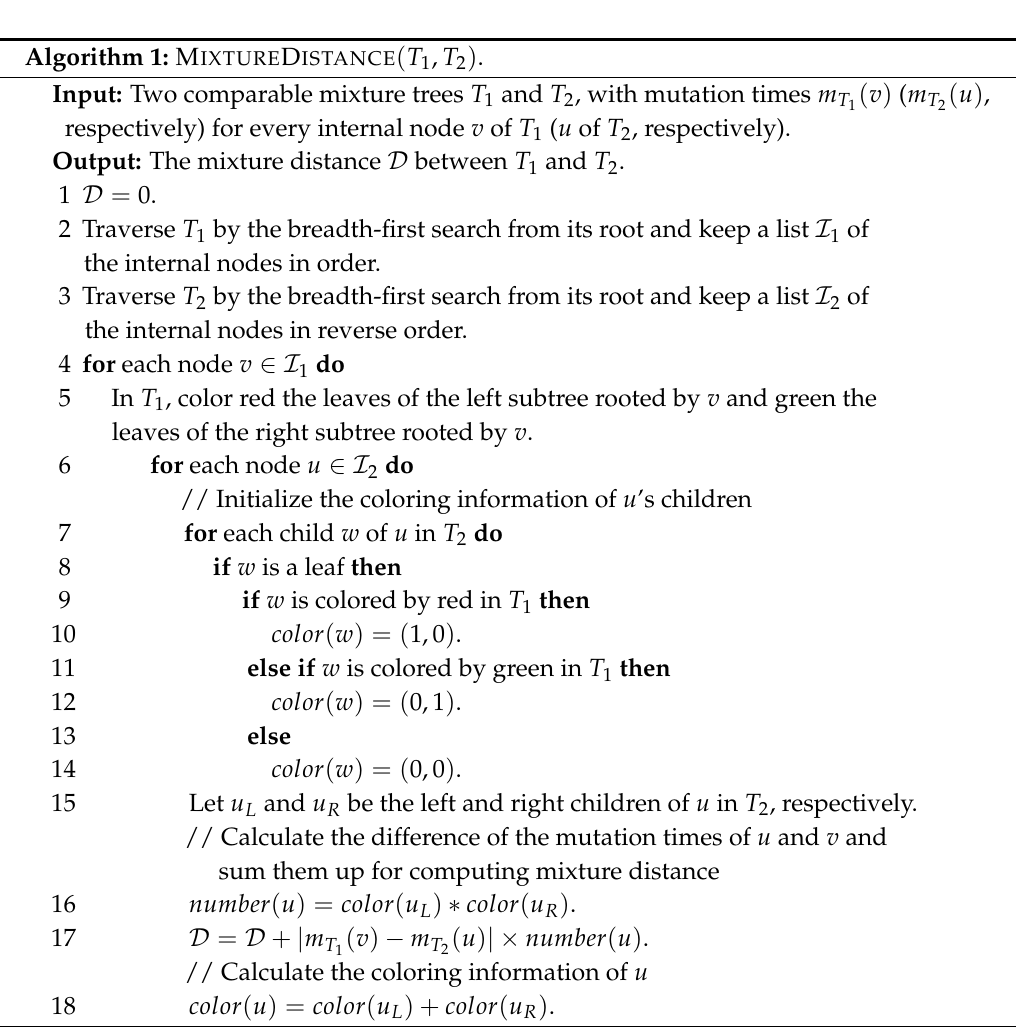
Algorithm 1: M IXTURE D ISTANCE ( T 1 , T 2 )